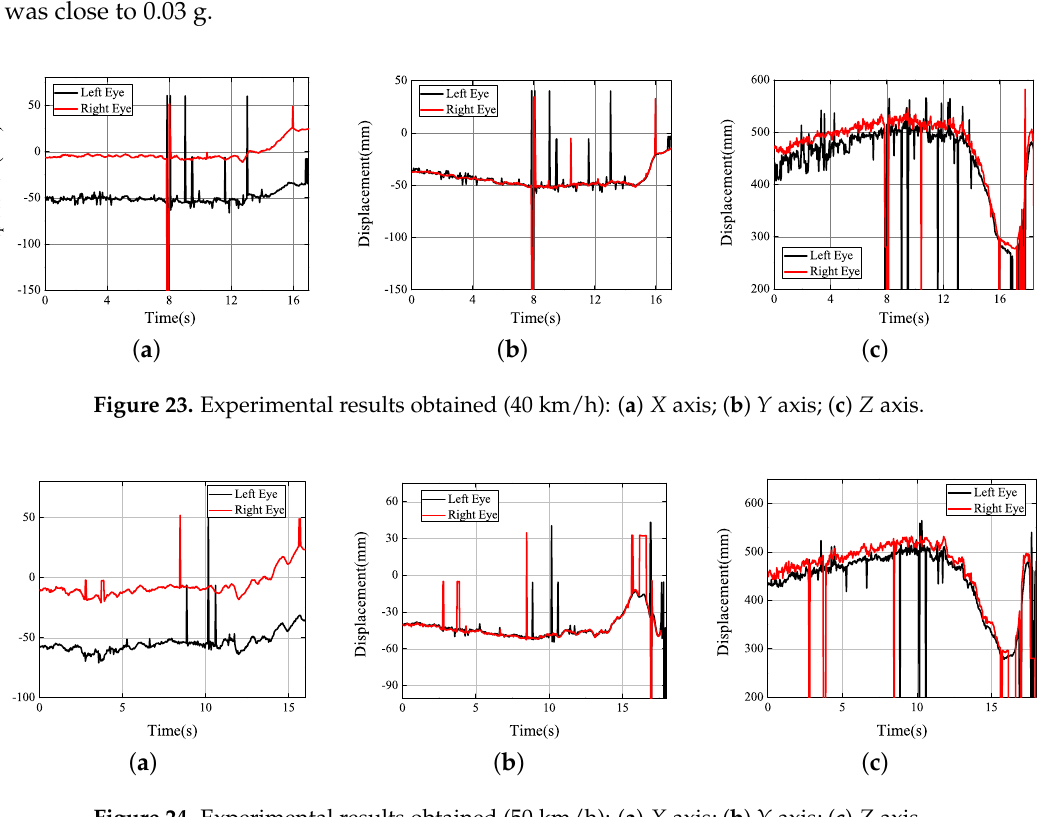
Figure 24. Experimental results obtained (50 km/h): ( a ) X axis; ( b ) Y axis; ( c ) Z